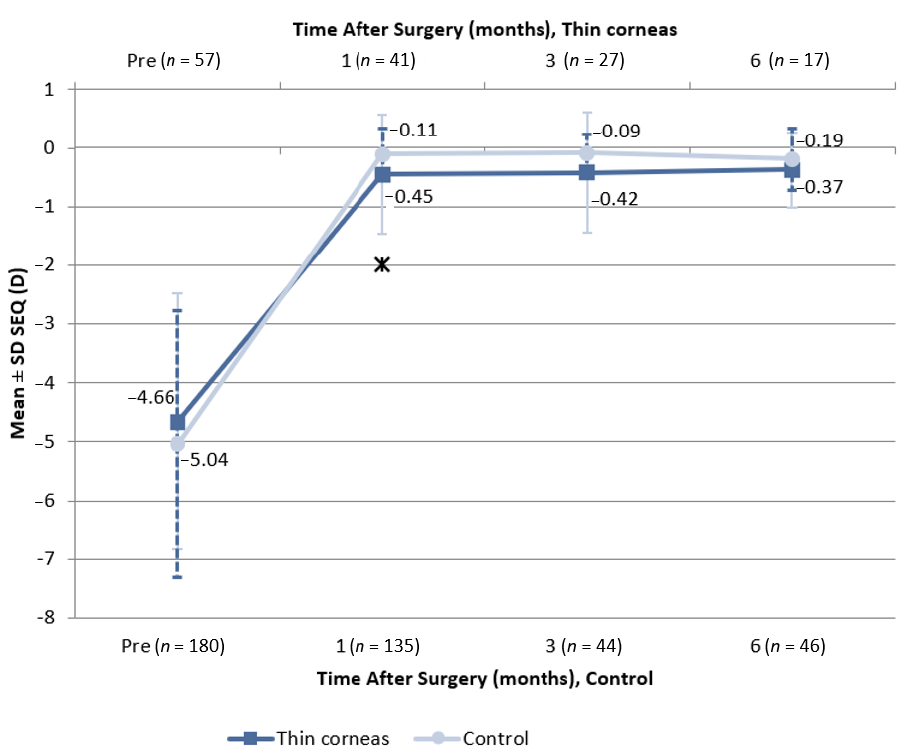
Figure 5. Spherical equivalent stability depending on baseline cornea thickness. Notes: SEQ — spherical equivalent; data are the means and standard deviations (SD); n — number of eyes; * – p -value < 0.05.